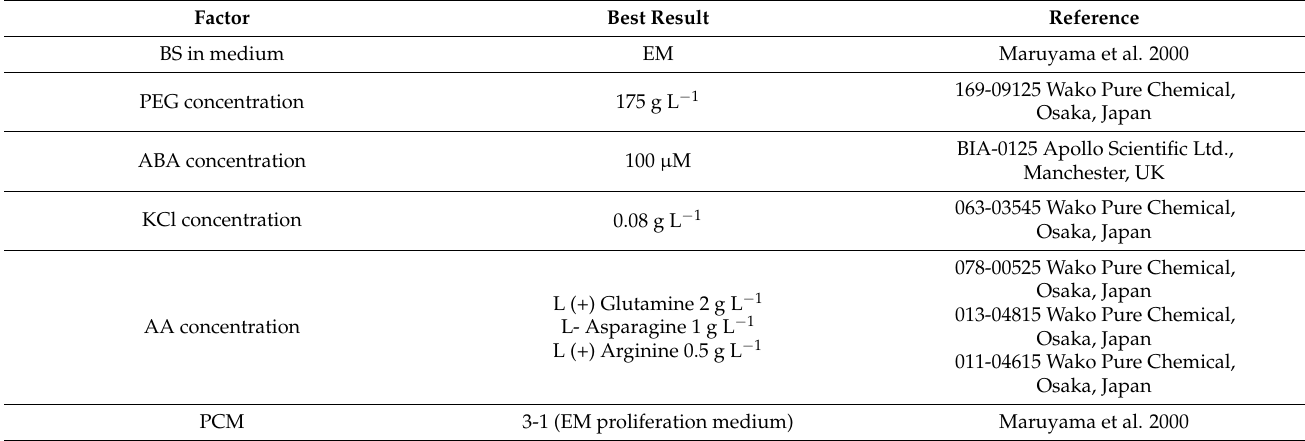
Table 13. Summary of the optimal factors giving the best results achieved in our six independent experiments including studies on the effect of basal salts (BS) contained in maturation medium, polyethylene glycol (PEG) concentration, abscisic acid (ABA) concentration, additional supplementation of potassium chloride (KCl), amino acid (AA) concentration, and proliferation culture media (PCM), as the main culture factors affecting somatic embryo maturation in